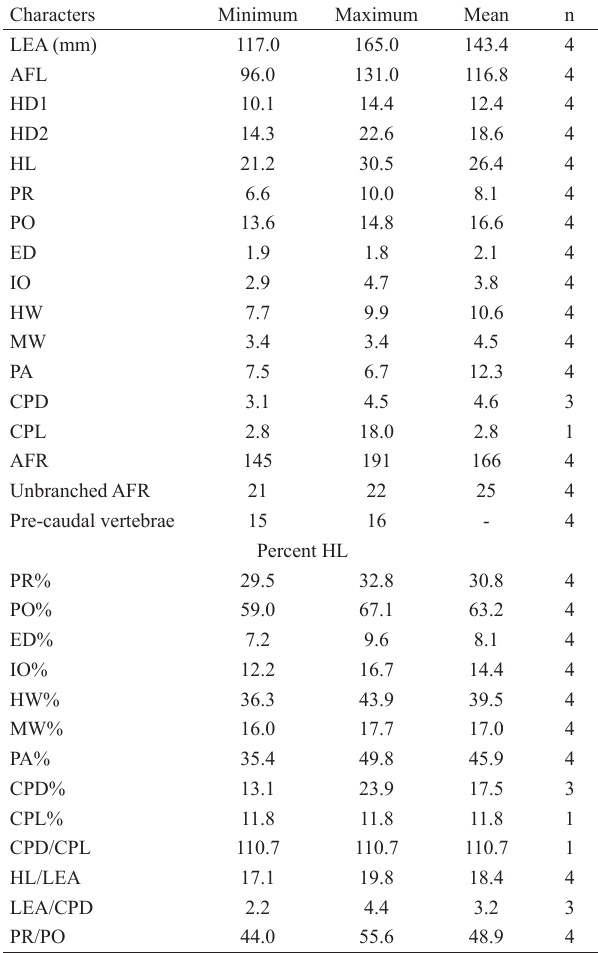
Fig. 24. Sternarchella schotti in lateral view (INPA 15801). a. Lateral view of the body. b. Lateral view of the head. c. Lateral view of the caudal region showing a single row of intermuscular bones in the caudal peduncle and a discontinuous caudal peduncle membrane. Scale bars = 1.5 cm. Tab. 9. Morphometrics and meristic measurements for Sternarchella